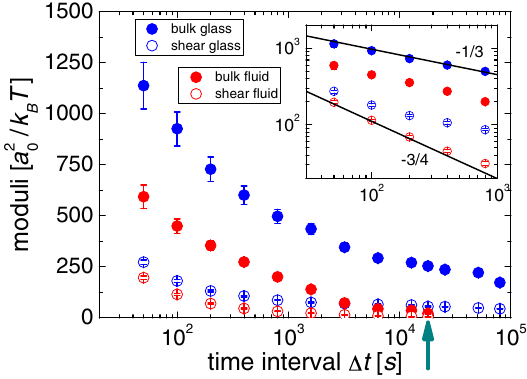
FIG. 5. Finite time effects investigated by varying the time interval Δ t used to determine the particle ’ s “ equilibrium position. ” On the glassy side, the shear modulus does not decay to zero even for the longest integration times. Data of the system are at Γ ¼ 287 in the solid (blue) and Γ ¼ 103 in the fluid (red) while the bulk and shear moduli are marked by filled and empty symbols. The inset shows the high-frequency region in the frozen state, which suggests a power-law behavior. Upper and lower black lines are functions with exponents − 1 and − 3 3 4